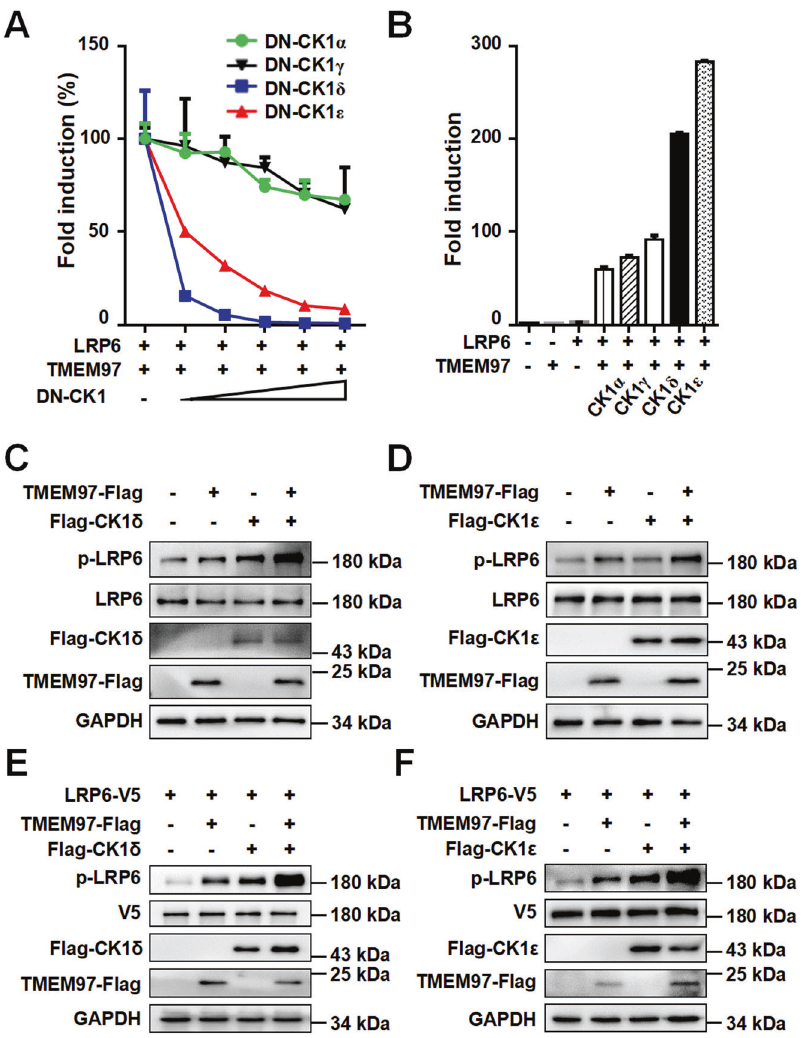
Fig. 4 TMEM97 enhances LRP6-mediated Wnt signaling in a CK1 δ / ε -dependent manner. A The SuperTOPFlash reporter gene was transfected into HEK293T cells together with expression vectors for TMEM97 and LRP6 in the absence or presence of increasing amounts